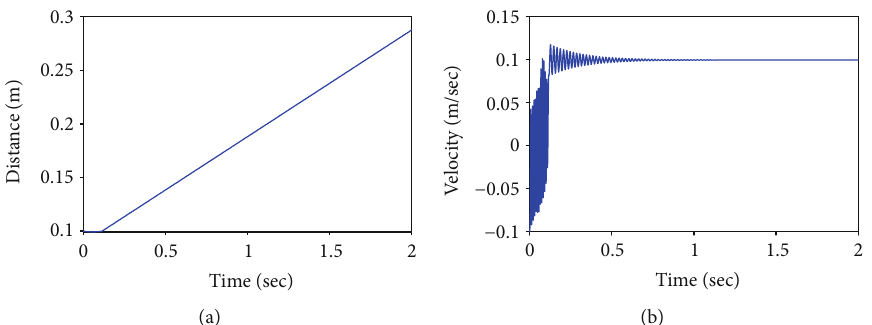
Figure 3: Dynamic response of two contact objects ( stiffness = 1 × 10 6 , damping = 100 ): (a) relative distance of S of S and S . 1 2